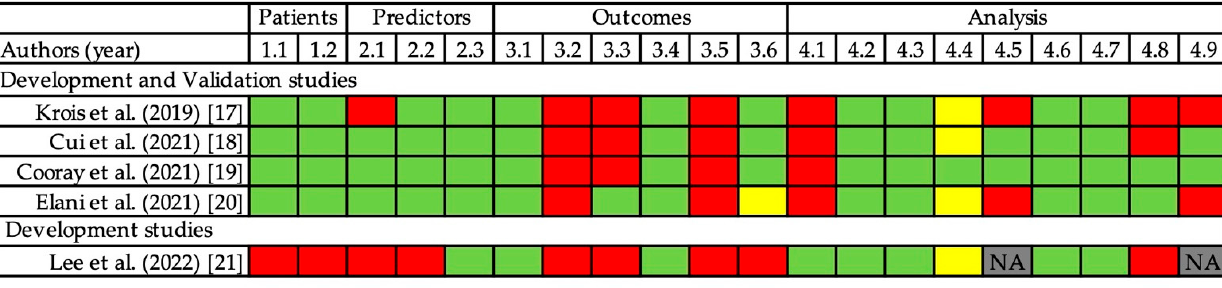
Figure 2. Risk-of-bias assessment with PROBAST signaling questions in four domains [14]. Low ( green ), high ( red ), unclear risk of bias ( yellow ), and not applicable (NA). PROBAST items: 1.1. Were appropriate data sources used? 1.2. Were all inclusions and exclusions of participants appro-